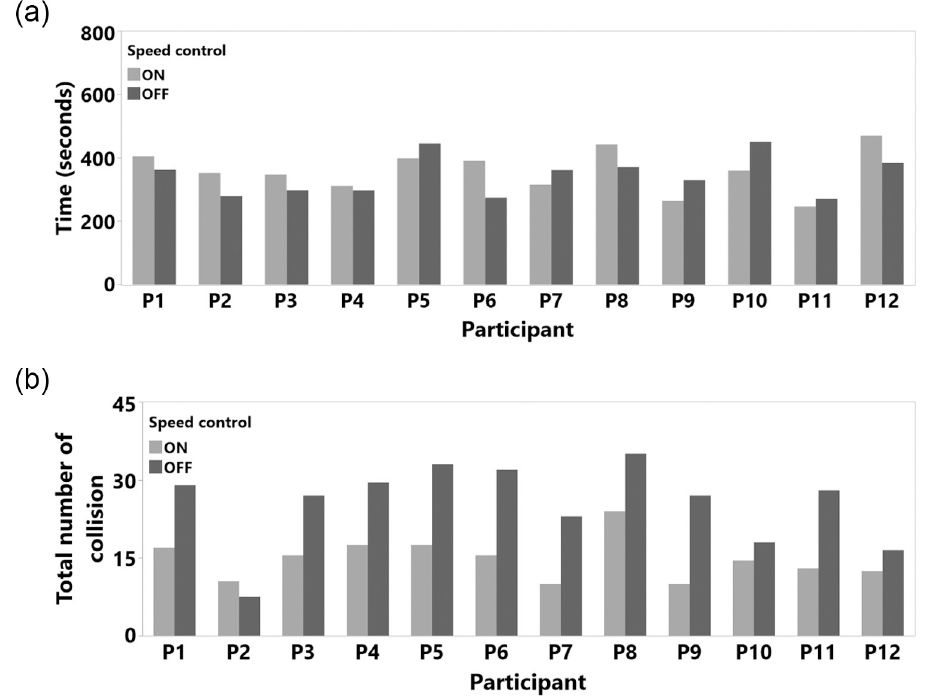
Fig 14. Study 1 participant results (a) total task completion time and (b) total number of collision.